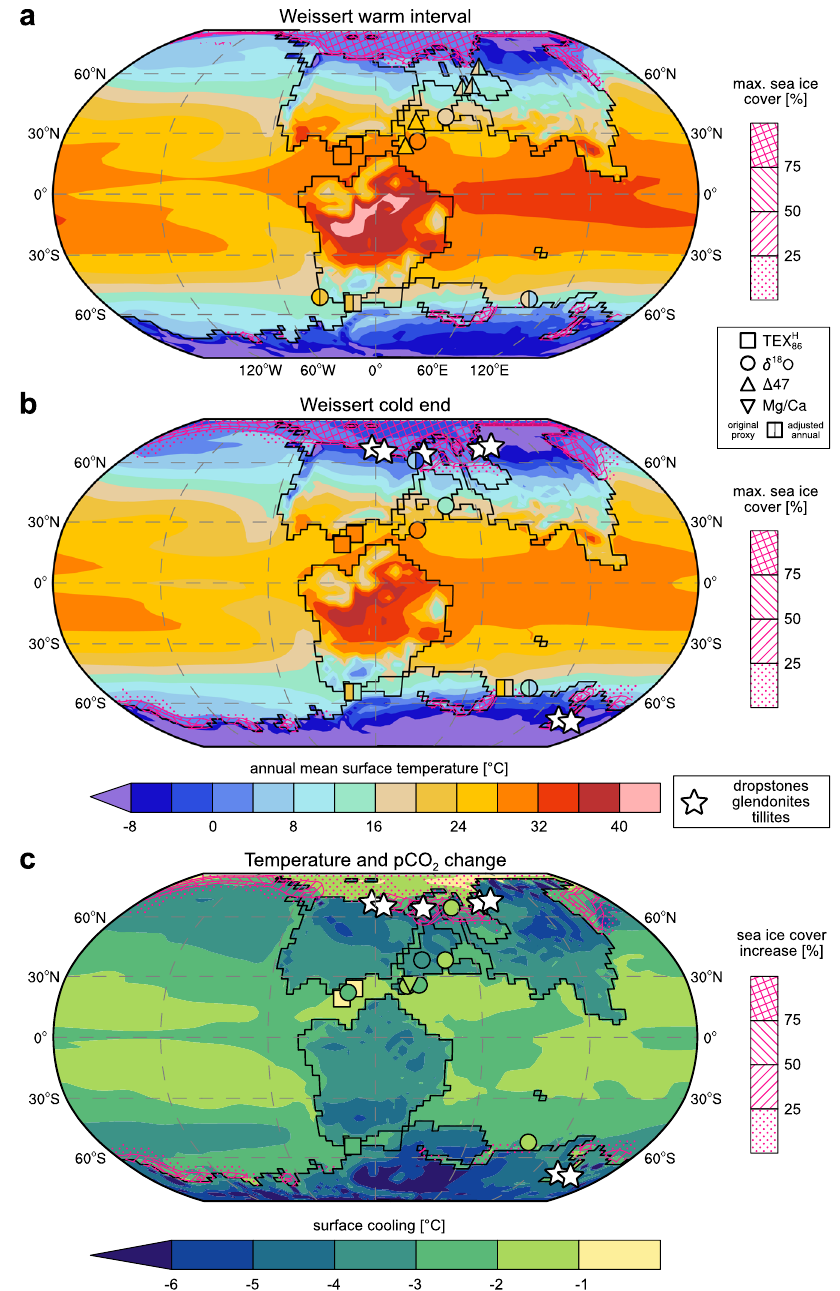
Fig. 5 Simulated and reconstructed annual mean surface temperatures and cooling across the Weissert Event. a Model fi elds combine surface air temperatures over land with sea surface temperatures (SSTs) over the ocean and are linearly scaled to the calculated mean p CO 2 estimates of 1181 ppm during the Weissert warm interval (Supplementary Equation 5). Pink contours show associated maximum monthly mean sea ice concentrations. Symbols represent available proxy information. High-latitude sites (poleward of 45 °) also show approximated annual mean temperatures where the model- estimated difference between summer and annual mean values is subtracted from the original proxy temperatures to correct for a possible seasonal warm bias and to facilitate the model-data comparison. b Annual mean surface temperatures during the Weissert cold end scaled to the mean p CO 2 estimate of 682 ppm. c Estimated surface cooling from the Weissert warm interval to the Weissert cold end, i.e. panel a minus b , with an associated p CO2 drop of both periods (Supplementary Table 2). The reduced standard of independent p CO 2 reconstructions 10 . Our results indicate a errors compared to the annual mean analysis document an drop in GMST of 3.0 °C (±1.7 °C) towards the Weissert CIE end overall more consistent distribution in simulated and recon- (Fig. 4c). This global cooling and the corresponding ~40% structed surface temperatures. Associated p CO 2 concentrations reduction in p CO 2 is independent of any seasonal bias under this assumption are ~1180 ppm (940 – 1480 ppm) and assumption (Supplementary Fig. 6), and in good agreement with ~680 ppm (550 – 840 ppm) for the Weissert warm interval and proxy estimates from carbon isotopes on terrestrial plant cold CIE end, respectively (Fig. 4), and therefore within the range records 13 .